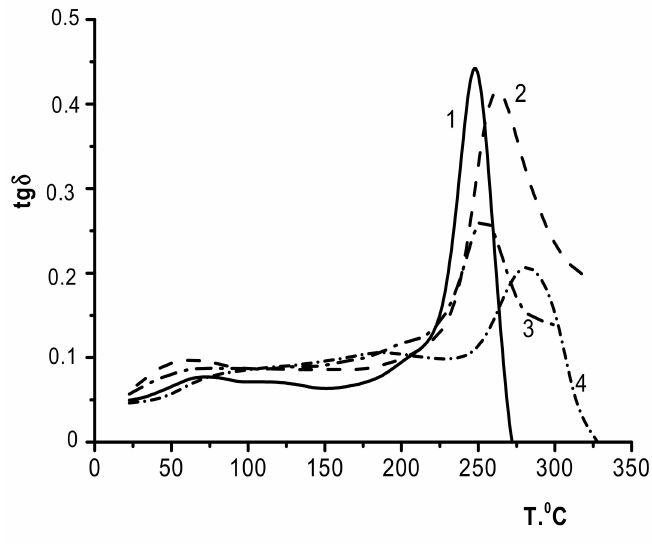
Figure 6. Temperature dependences of the mechanical loss tangent: 1, SEC; 2, CS b –PEC SEC ; 3, CS s – PEC SEC –SEC; and 4, CS b .